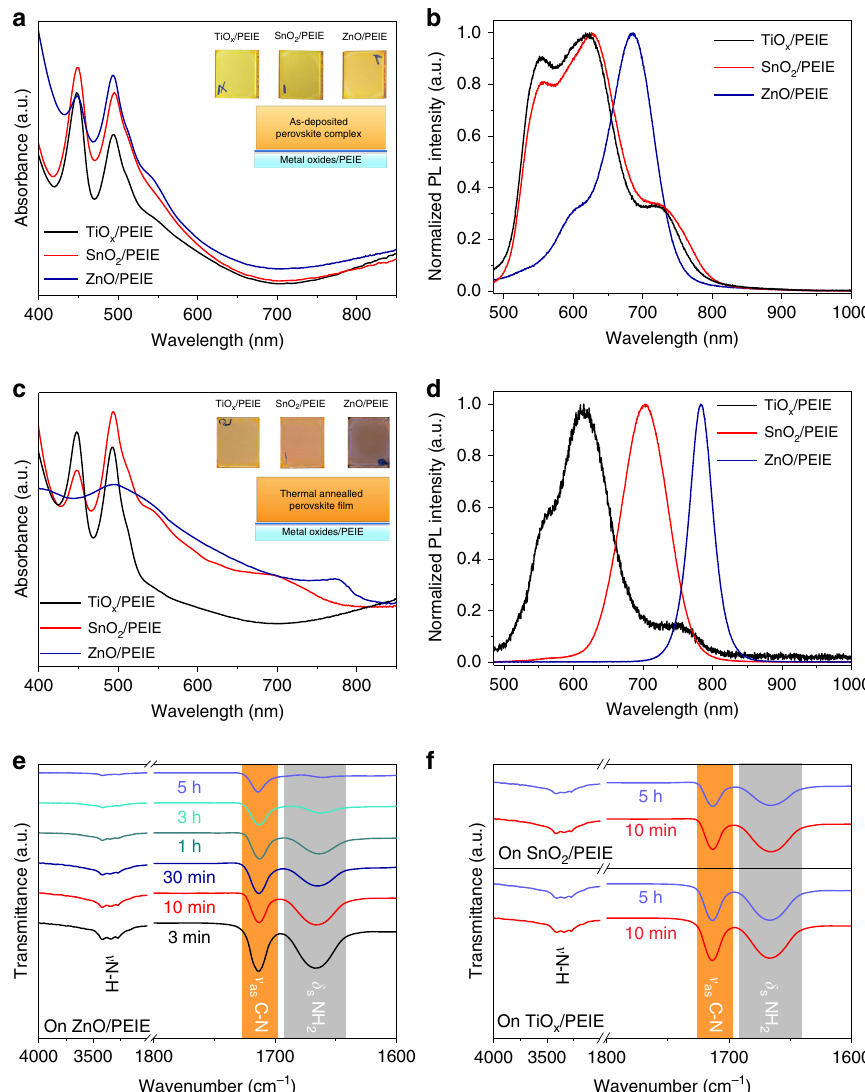
Fig. 3 Optical characteristics of perovskite fi lms ( x = 2.5) on different substrates. a – d UV-Vis absorption ( a , c ) and normalized PL spectra ( b , d ) of the perovskite fi lms on TiO x /PEIE, SnO 2 /PEIE and ZnO/PEIE substrates, respectively before ( a , b ) and after the thermal annealing ( c , d ). Insets show the corresponding photographs of the perovskite fi lms on different substrates. e – f FTIR spectra of perovskite fi lms on ZnO /PEIE ( e ), TiO x /PEIE and SnO 2 /PEIE ( f ) substrates with different annealing